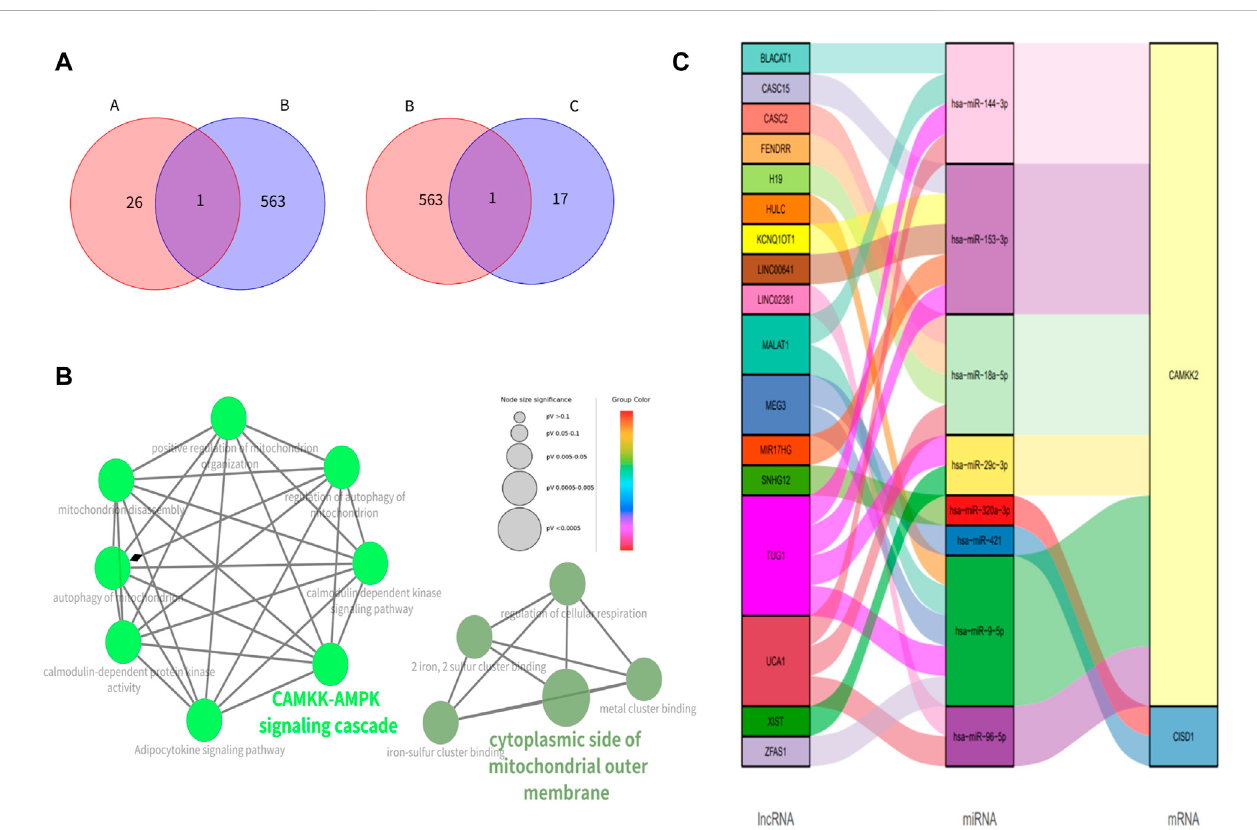
FIGURE 3 Identi fi cation of genes related to ferroptosis, enrichment analysis of ferroptosis-associated genes and construction of ceRNA networks (A) The Venn fi gure for intersected genes in FerrBD and different modules (A: black module; B: FerrBD; C: magenta module) (B) Functional enrichment of CISD1 AND CAMKK2. The signal pathways were discovered by enrichment analysis into groups based on functional connection, the same group was colored the same color,andthelabelsofeachgroupofthemostessentialtermswerecolor-coded. (C)